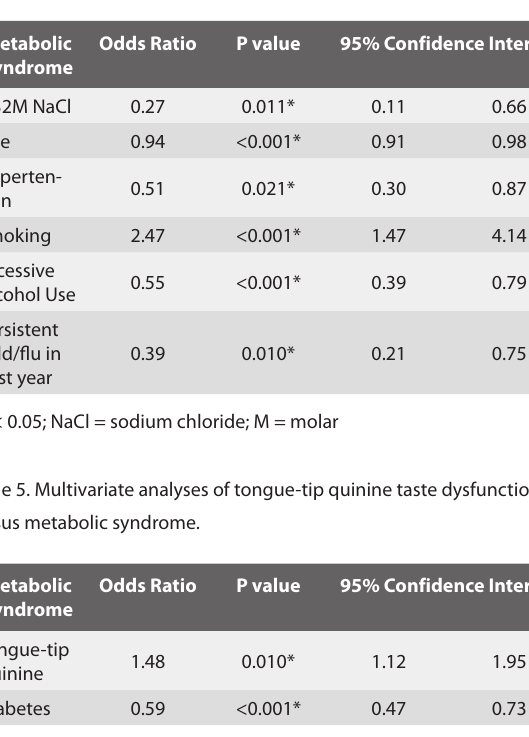
Table 4. Multivariate analyses of 0.32M taste dysfunction versus obesity.